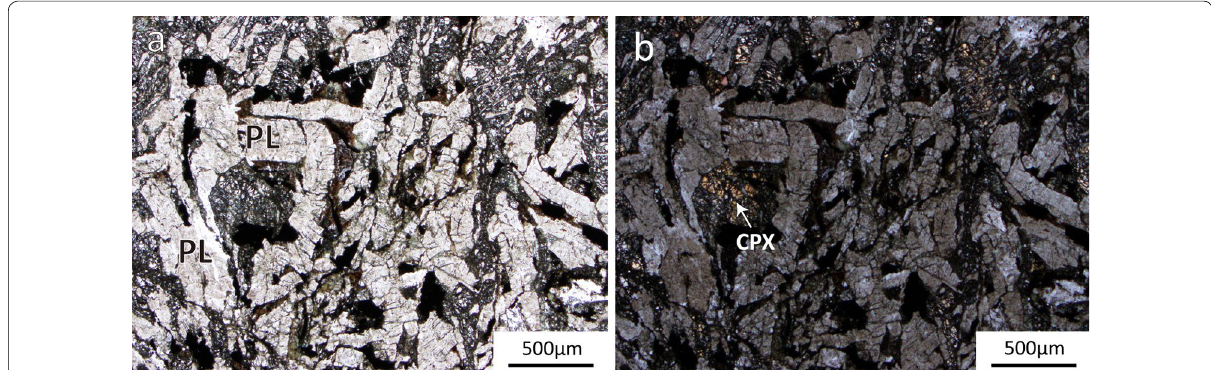
Fig. 2 Representative photomicrographs of intact pillow basalt (sample OKB) under plane-polarized ( a ) and cross-polarized ( b ) light; PL plagioclase, CPX